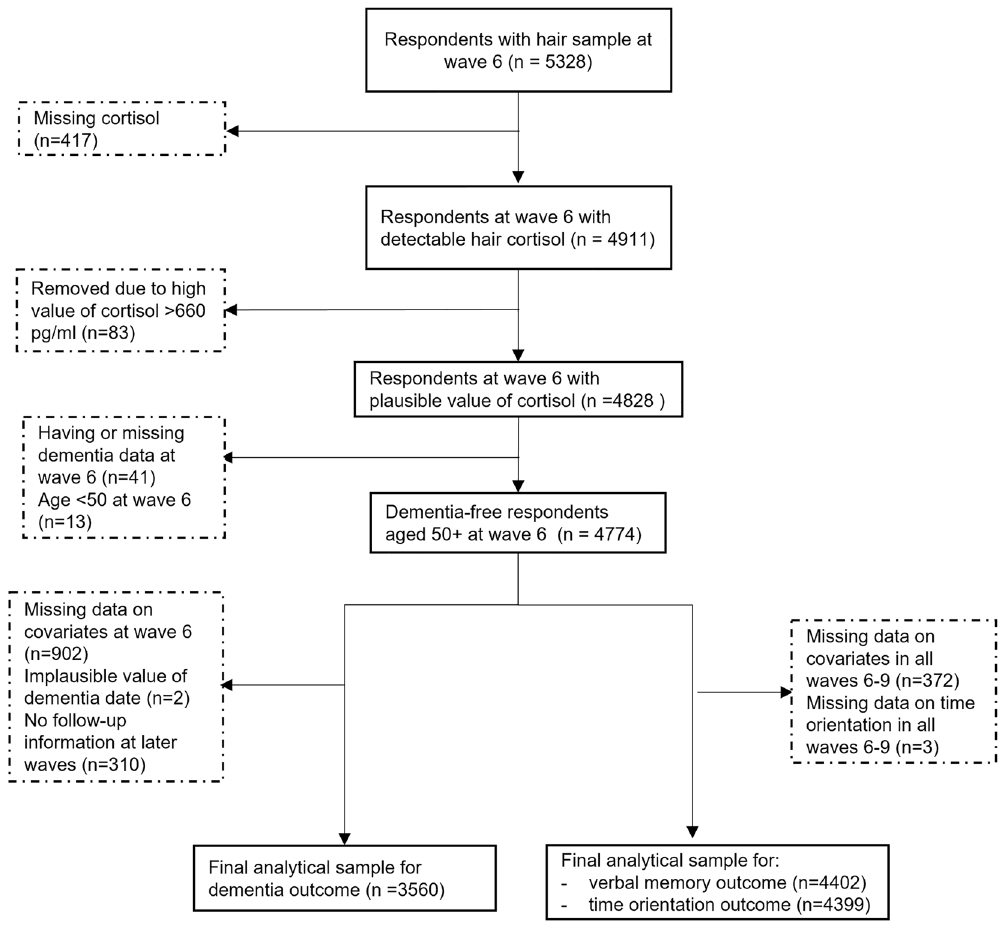
Figure 2. Flowchart of the analytical sample of hair